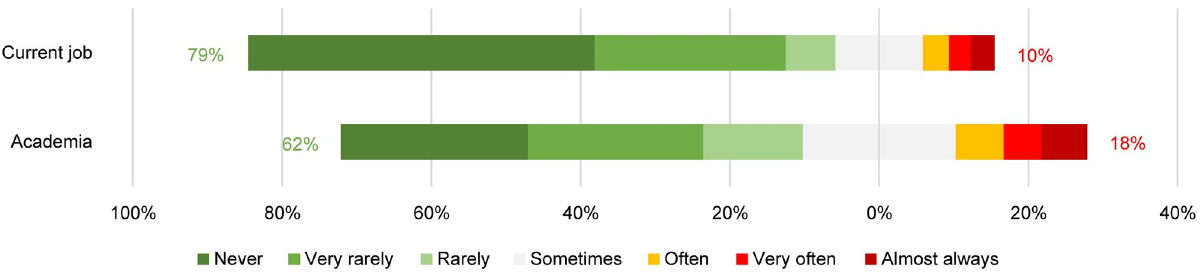
Fig 6. Frequency of PhD candidates seriously considering quitting their current job and